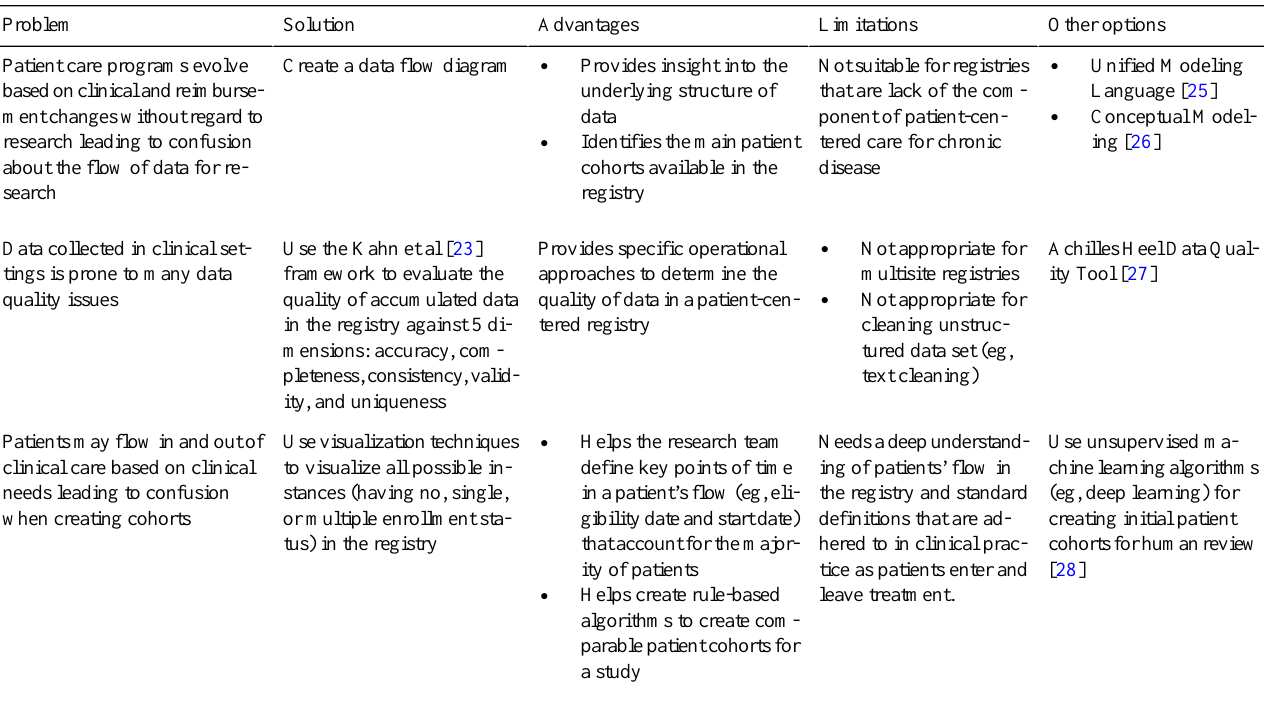
Table 3. A summary of the analytical framework suggested in this